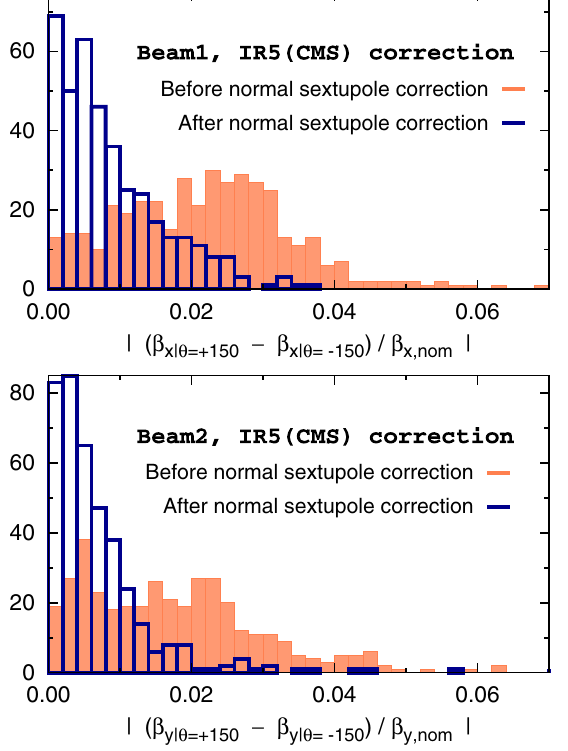
FIG. 16. Histograms of Beam 1 (top) and Beam 2 (bottom) beta-beating measured at LHC BPMs, before (blue) and after (red) normal sextupole compensation in IR5 (CMS).